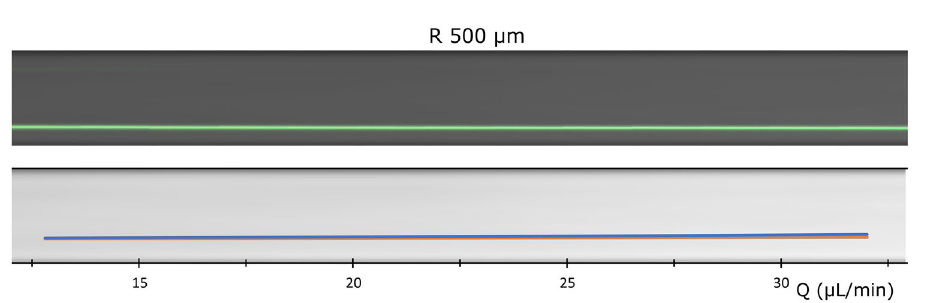
Figure 7. Performance of the focusing section (two loops with R 500 µm followed by 250 µm of straight segment, 6.15 × 14.5 µm ( W × H )) with 0.79, 0.92 and 1.0 µm particles. Experimental (top) and prediction by the model